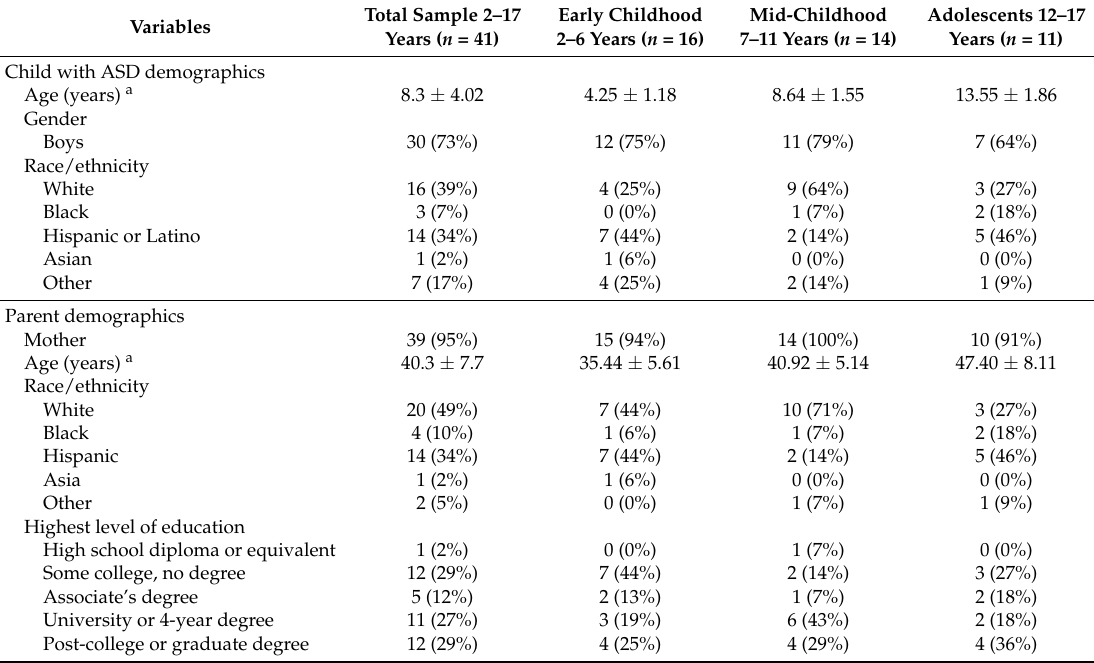
Table 1. Demographic characteristics of study